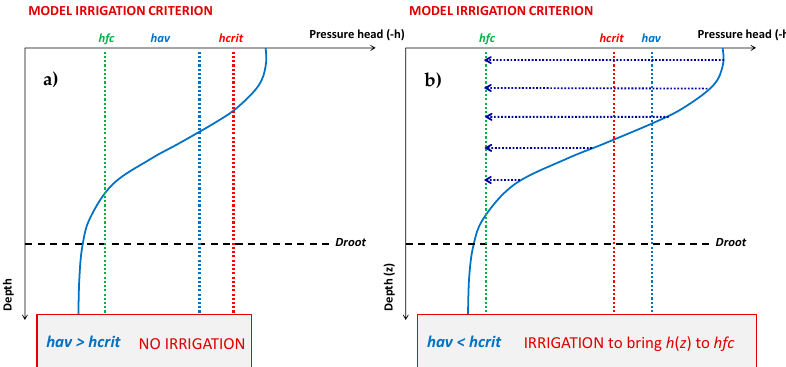
Figure 1. Graphical view of the criterion used by the model to calculate the time for irrigation and the irrigation volume. ( a ) hav higher than hcrit , no irrigation is required; ( b ) hav lower than hcrit , irrigation is required to bring the pressure head at the field capacity, hfc .